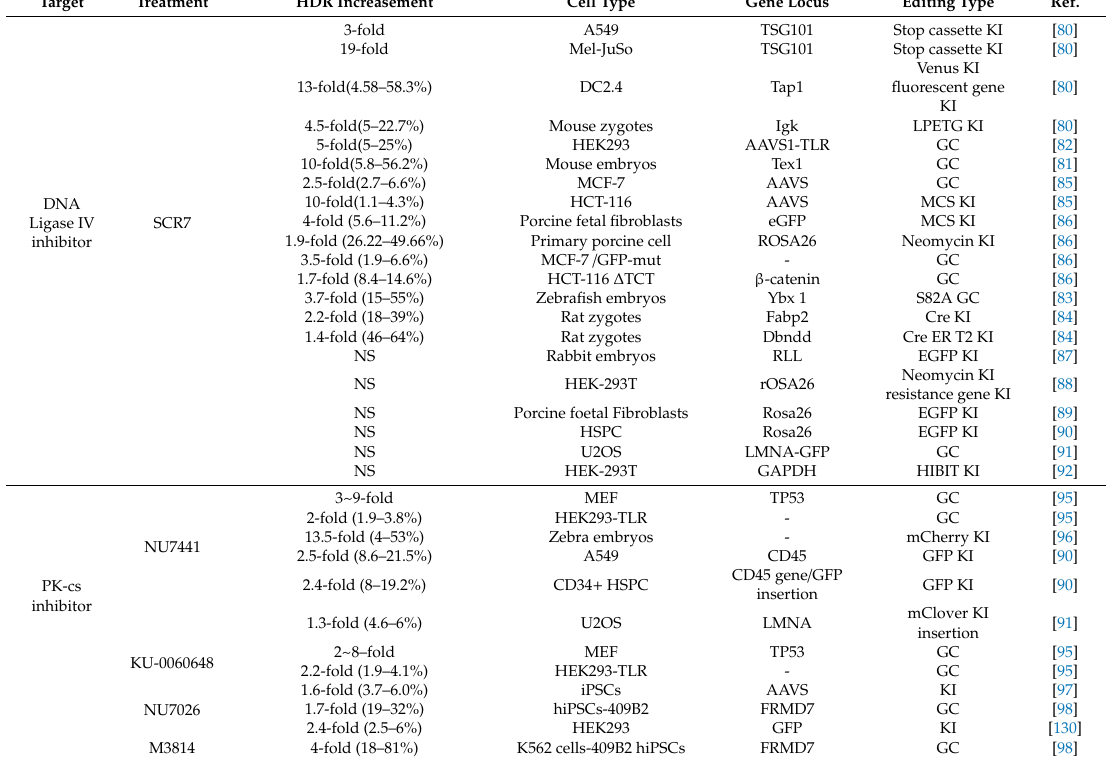
Table 1. Selected small molecules used in favoring the choice of Cas9